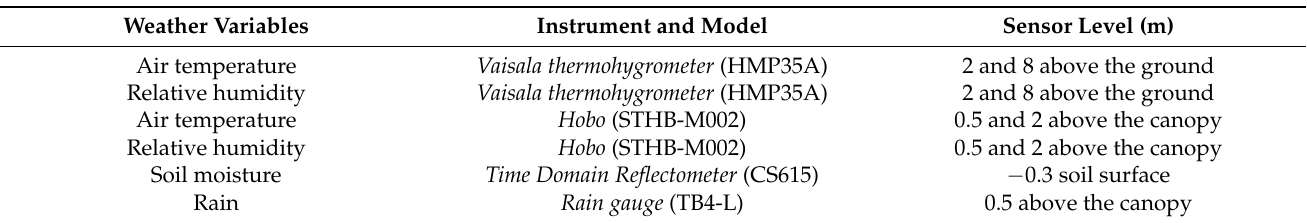
Table 1. Variables and instruments used in the experiment, as well as their arrangement in relation to the soil and the plant